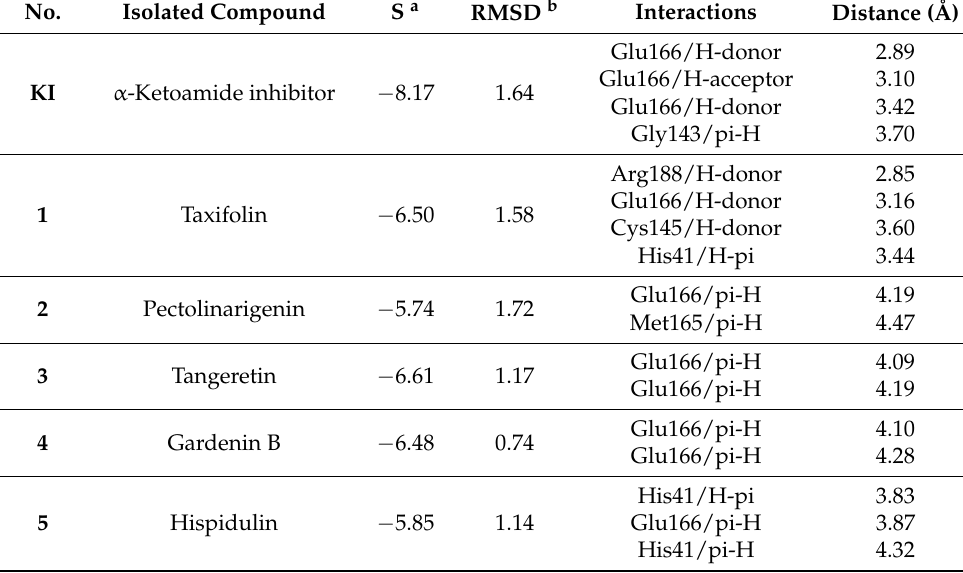
Table 1. The binding scores and interactions of the docked KI in addition to the five examined flavonoids ( 1 – 5 ) inside the SARS-CoV-2 Mpro